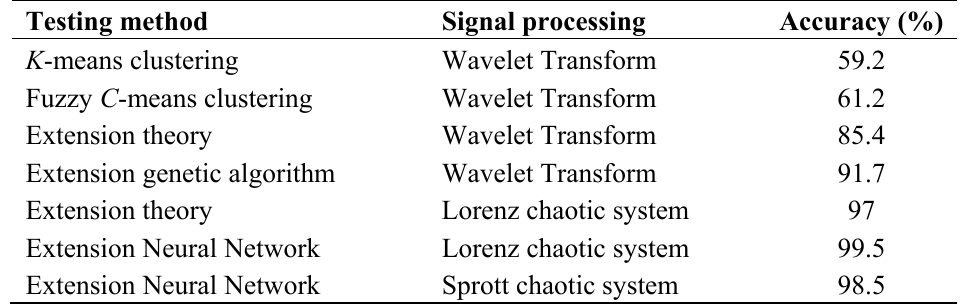
Table 2. Comparison of detection performance of proposed CS-based methods with that of existing